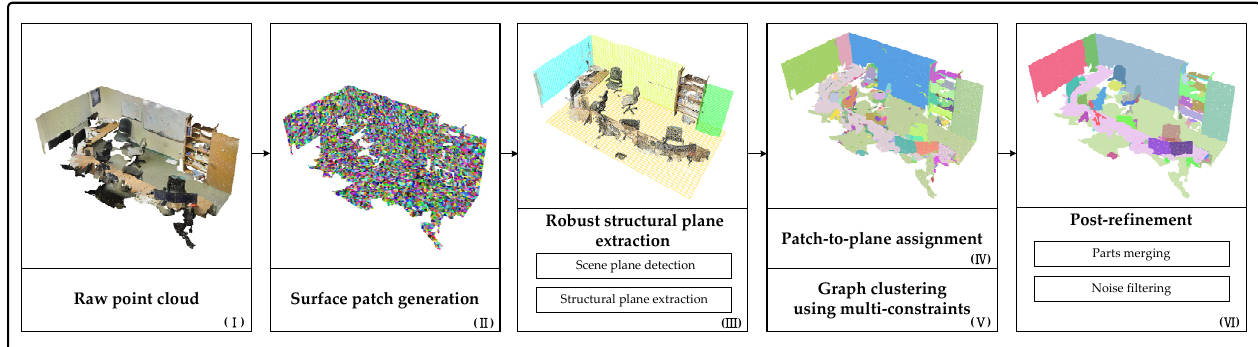
Figure 1. Pipeline of the proposed multi-constraint graph clustering based 3D segmentation